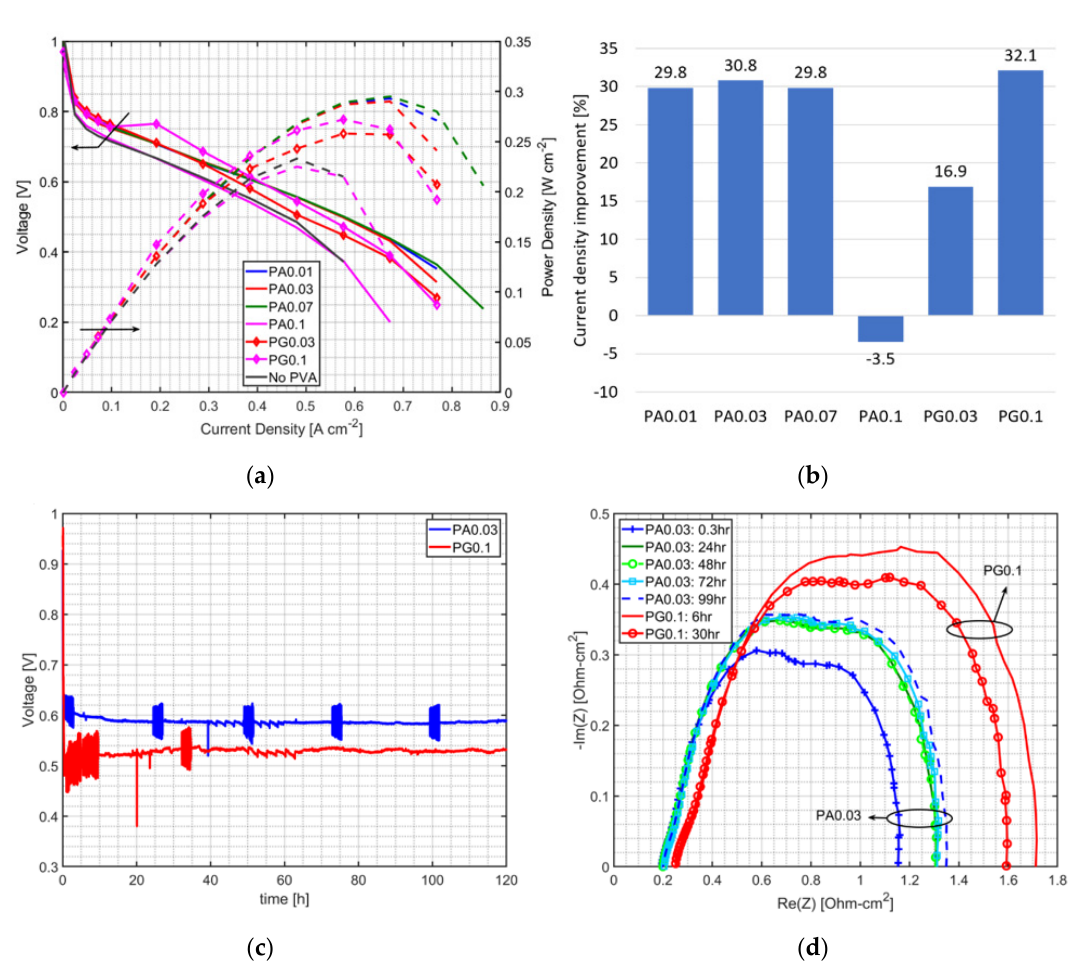
Figure 7. ( a ) Comparison of PEMFCs using PVA-MEA prepared by the PA and PG methods at a non-humidified anode and cathode humidifier temperature of 25 °C, ( b ) percent improvement of PVA-MEA from MEA without PVA at the non-humidified anode, with a cathode humidifier temperature of 25 °C and a voltage of 0.6 V, ( c ) the durability test and ( d ) the impedance curve of PA0.03 and PG0.1 at a constant current density of 0.4 A cm − 2 , with a non-humidified anode and a cathode humidifier temperature of 25 °C.